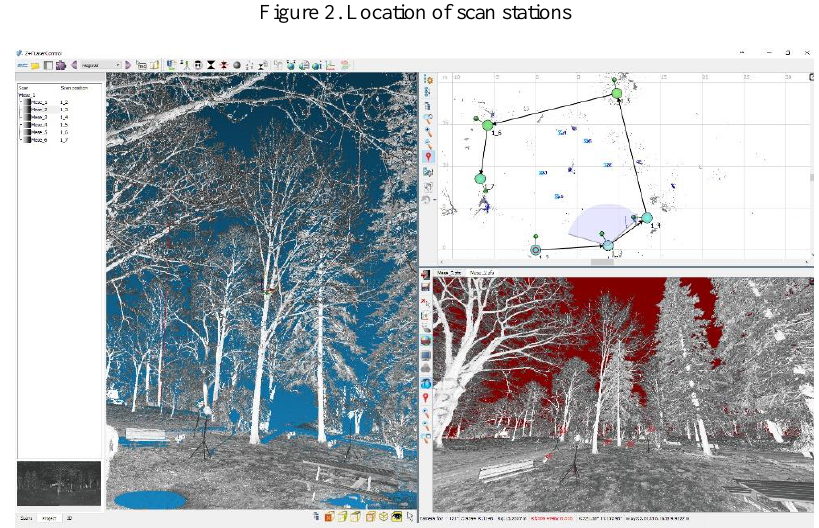
Figure 3. Registration screen of point cloud